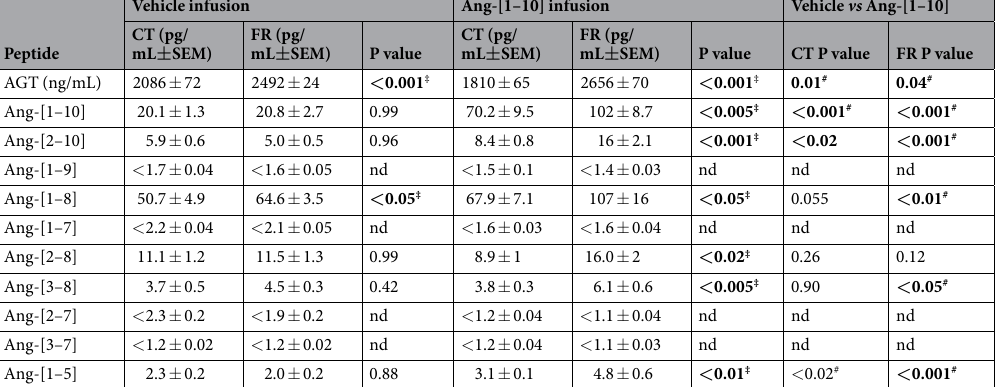
of the hypothalamus of the spontaneously hypertensive rat when compared to Wistar Kyoto normotensive con- trols 28 . However, other studies have found ACE and ACE2 can act coordinately. The mRNA & protein expres- sion of both ACE and ACE2 were reduced by diabetic nephropathy in kidney tubules 29 . Although FR caused a